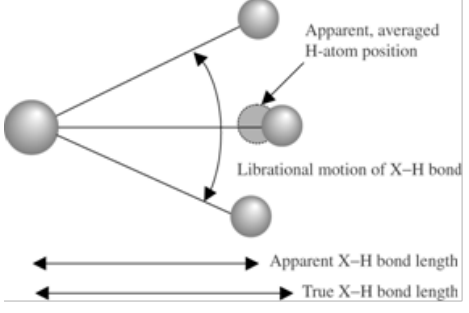
Figure 2. Librational apparent shortening of bonds to hydrogen (reproduced with permission from